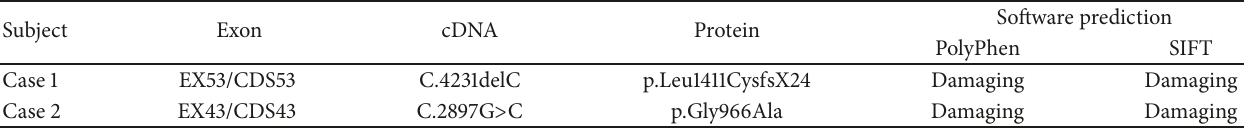
Table 1: Mutations in COL2A1 for the 2